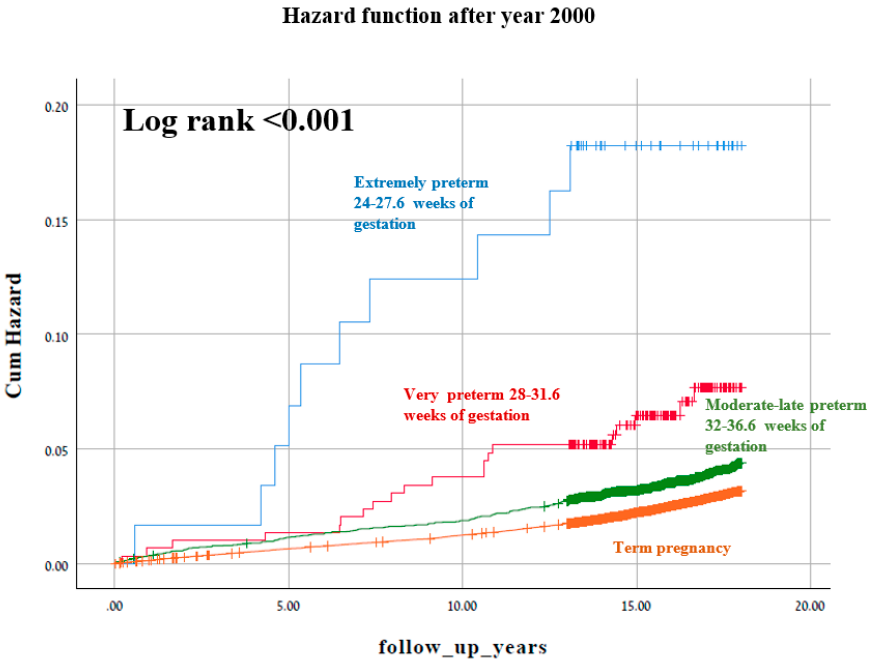
Figure 2. A Kaplan–Meier survival curve demonstrating the cumulative incidence of long-term neu- rologic-related hospitalizations according to gestational age before year 2000 (Log-Rank test p < 0.001).